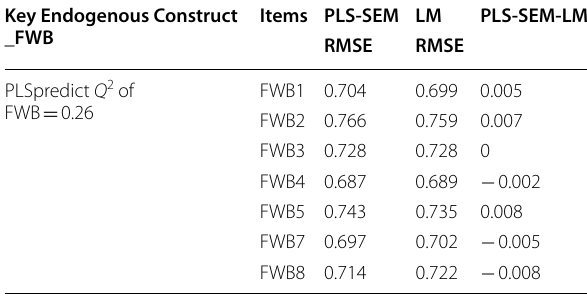
FWB Financial well-being; Partial least squares structural equation model = (Analysis sample); LM Linear regression model (Holdout sample); RMSE = mean-squared